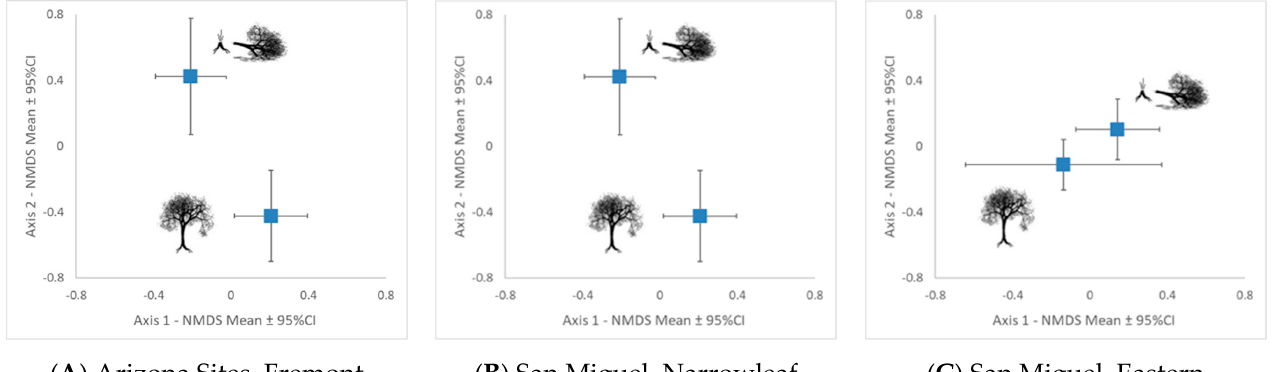
Figure 3. Non-metric multidimensional scaling (NMDS) compared chemistry profiles of juvenile felled and unfelled cottonwood twigs: ( A ) Fremont cottonwoods in Arizona had significant effects for Site (Dry Beaver Creek, Verde River; A = 0.125; p < 0.0001) and Treatment (Figure shown: Felled, Unfelled; A = 0.016, p = 0.0163) and a significant Site × Treatment interaction (A = 0.144, p < 0.001). ( B ) In narrowleaf cottonwoods on the San Miguel River, there was also a significant difference between the chemical composition of resprout growth and twigs from unfelled trees (A = 0.123, p < 0.0001); ( C ) Eastern cottonwoods on the San Miguel River, CO showed no significant difference in chemistry profiles between felled and unfelled trees (A = − 0.005, p = 0.59). Icons represent felled and unfelled profiles; centroids are mean values with 95% confidence intervals. Table 1. Chemistry composition was significantly different in twigs collected from juvenile resprout growth than in juve- nile twigs from unfelled trees in Arizona and in Colorado. When we analyzed each chemical independently, we found no significant difference between Arizona sites for carbon, lignin or nitrogen, so these sites were pooled for analyses. The directionality of each difference, if any, along with the corresponding p -value is reported. All analyses were conducted using a non-parametric Wilcoxon-Signed Rank Test, and Bonferroni adjusted for an α of 0.007 for Fremont and Eastern cottonwood and 0.008 for narrowleaf cottonwood. p -values with two asterisks ** are significant with Bonferroni-adjusted α . p -values with one asterisk * are significant prior to Bonferroni adjustments. In Fremont cottonwood, we found signifi- cant differences in 5 out of 7 analyses when using Bonferroni adjustments and in 6 out of 7 analyses without Bonferroni adjustments. In narrowleaf cottonwood, we found significant differences in 4 out of 6 analyses both with and without Bonferroni adjustments. In Eastern cottonwood, we found a significant difference in 1 out of 5 analyses (nitrogen), but significance was not maintained with Bonferroni adjustments.